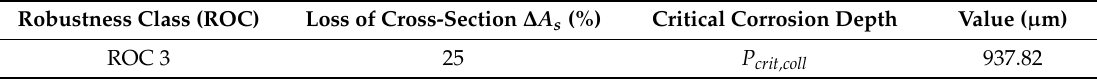
Table 17. Critical corrosion depth P crit,coll for ROC3, derived for bridge wings.